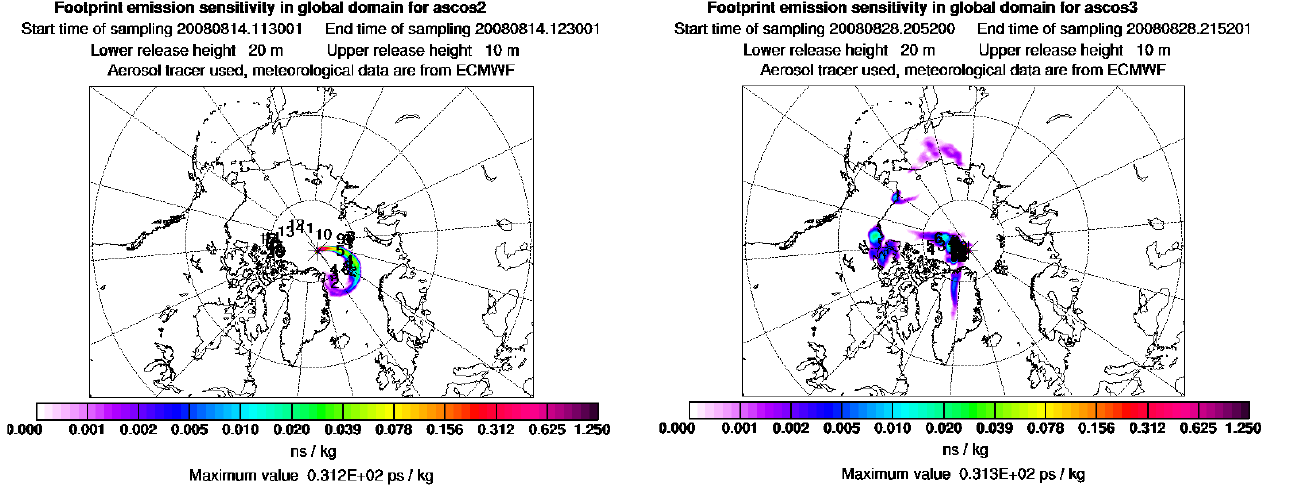
Figure 6. Footprint potential emission sensitivity for 14 Au- gust 2008 (DoY 227) obtained from FLEXPART. The receptor, i.e., Oden , is marked with an asterisk. The numbers (in days back- ward) plotted on top of the map represent a daily retroplume product that roughly indicates the transport speed. The emission sensitivity (in units of skg − 1 ) is proportional to the particle residence time in a grid cell of the “footprint layer” and measures the simulated mix- ing ratio at the receptor that a source of unit strength (1kgs − 1 ) in the cell would produce.